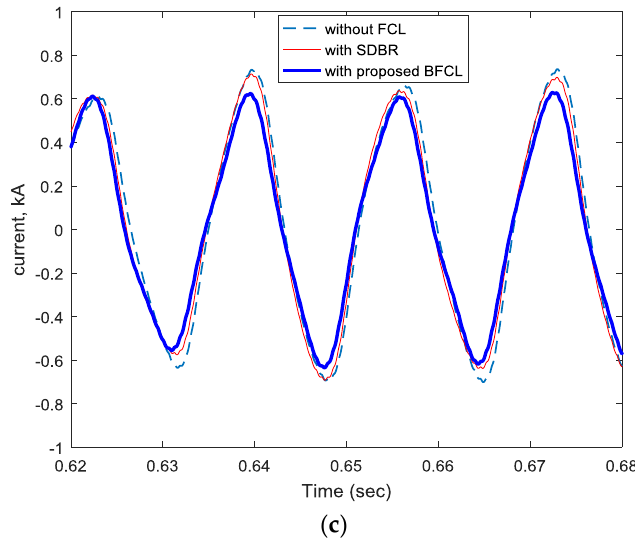
Figure 8. Comparative transient response of a two grids-connected VSC-HVDC system subject to a 1LG fault at grid1 ( a ) DC link voltage ( b ) Grid1 active power flow ( c ) Phase ‘a’ current of grid1.